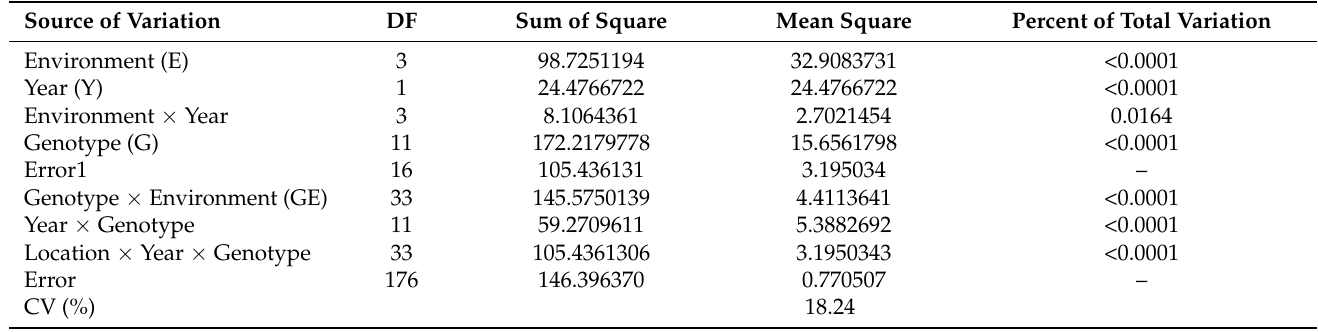
Table 4. Combined analysis of variance for grain yield of 12 maize hybrids in 4 locations and 2